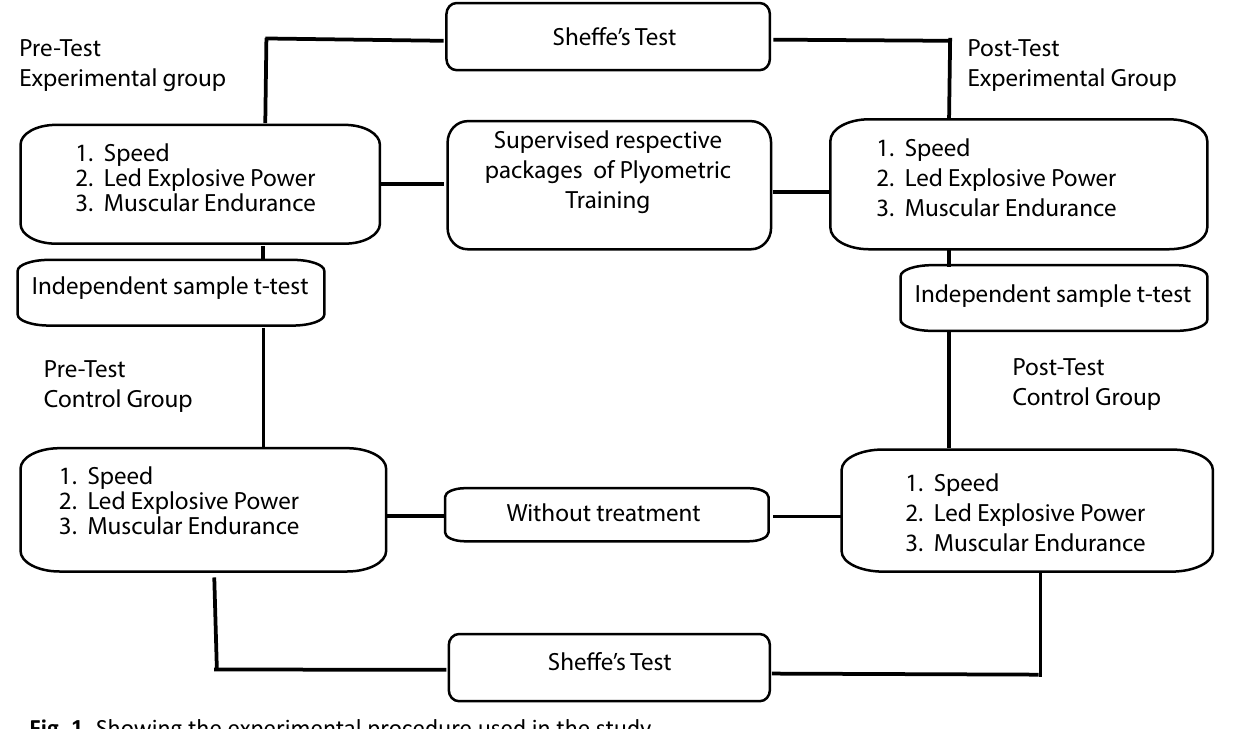
Fig. 1. Showing the experimental procedure used in the study Table 1. Showing the description of selection of the tests S.